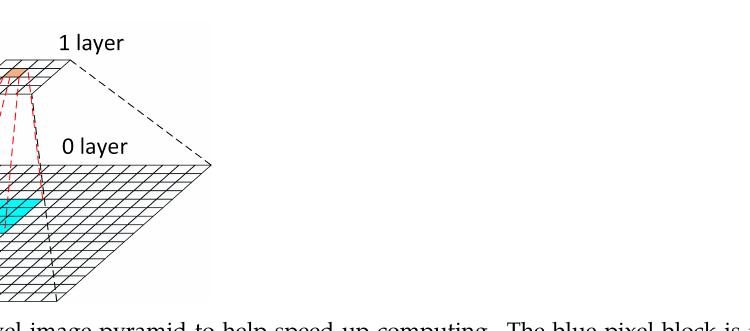
Figure 3. A two-level image pyramid to help speed up computing. The blue pixel block is the mapping result of the brown pixel block in layer